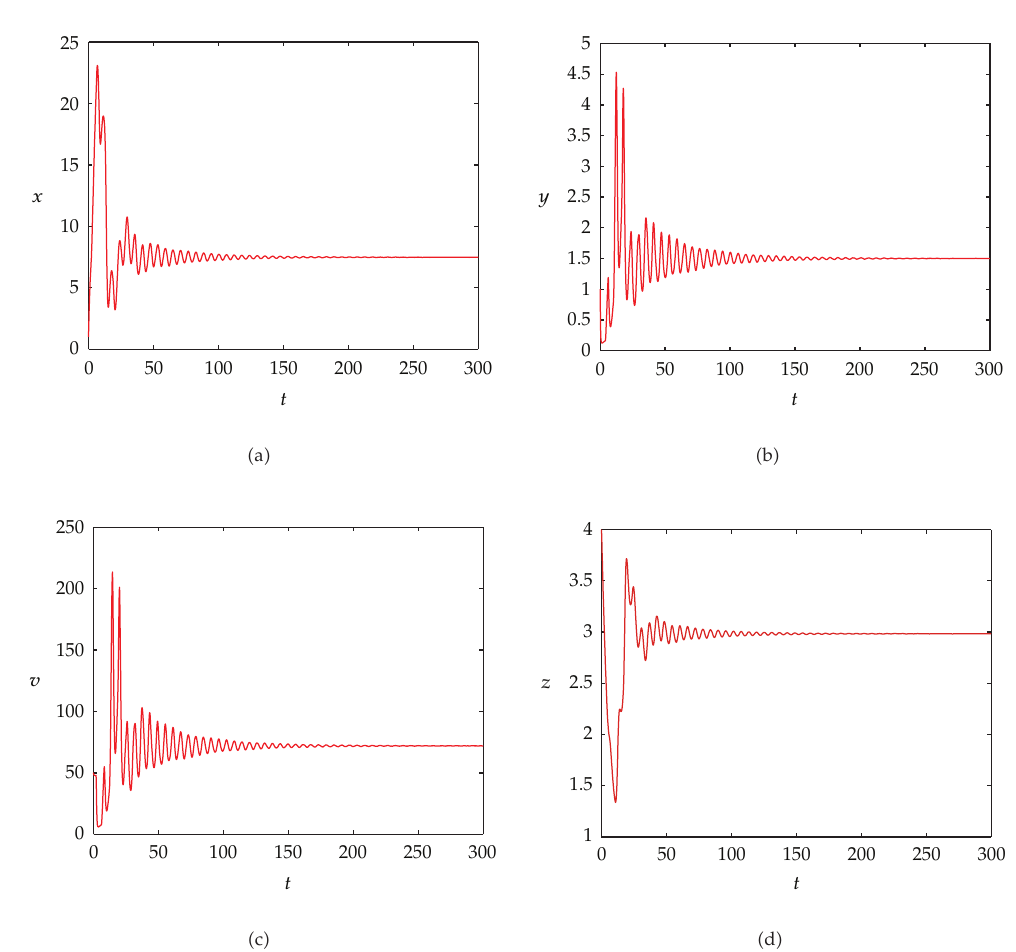
Figure 3: The CTL-activated infection equilibrium E 2 of system (cid:2) 1.2 (cid:3) is globally asymptotically stable. Here τ 1 (cid:7) 4, τ 2 (cid:7) 2, and the initial value is (cid:2) x 0 (cid:7) 1 , y 0 (cid:7) 1 , v 0 (cid:7) 50 , z 0 (cid:7) 4 (cid:3) .